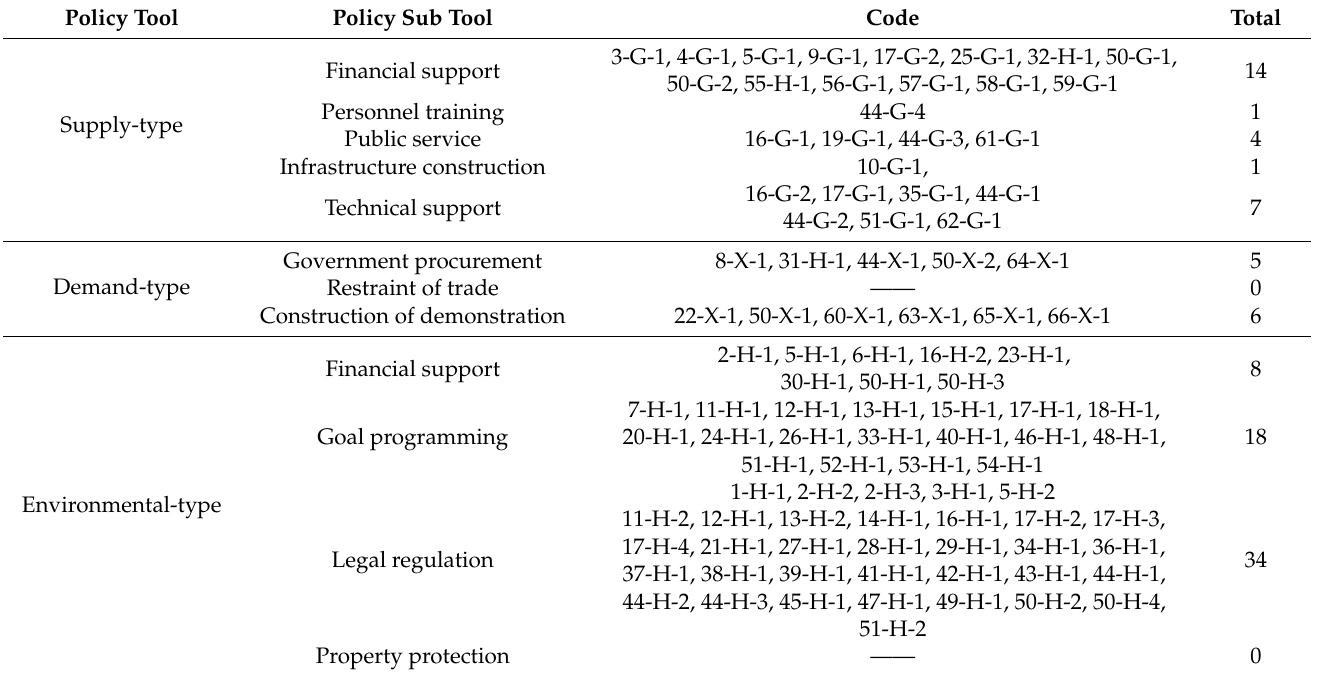
Table 3. Usage of three policy tools.